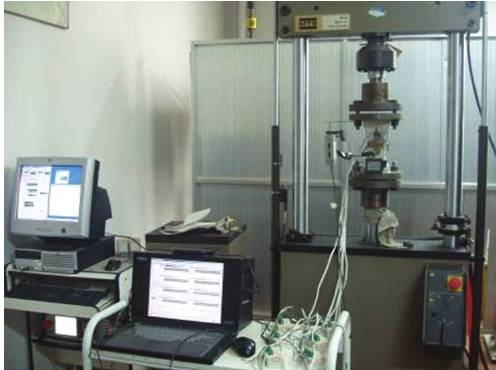
Figure 5: MTS810 Electrohydraulic dynamic-static universal test- ing